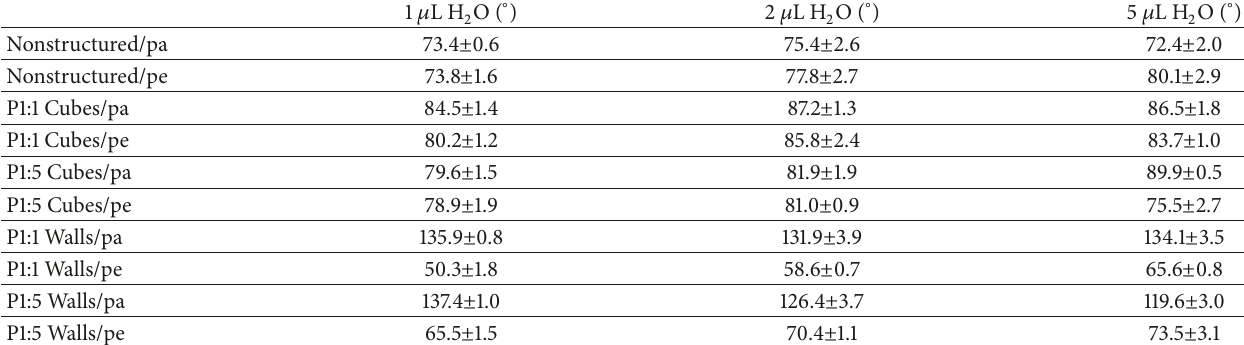
Table 2: Contact angles of water as a function of droplet volume and substrate topography.